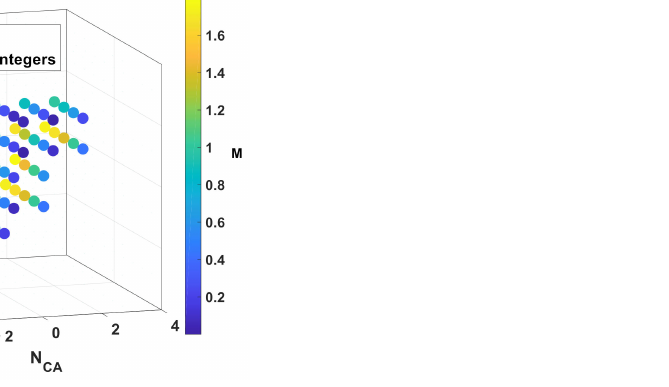
Figure 4. The Feasible Set of the proposed cost function in 3D. The red point is target ambiguity integers and other points (circle with color in image) are feasible set with color indicating cost value.